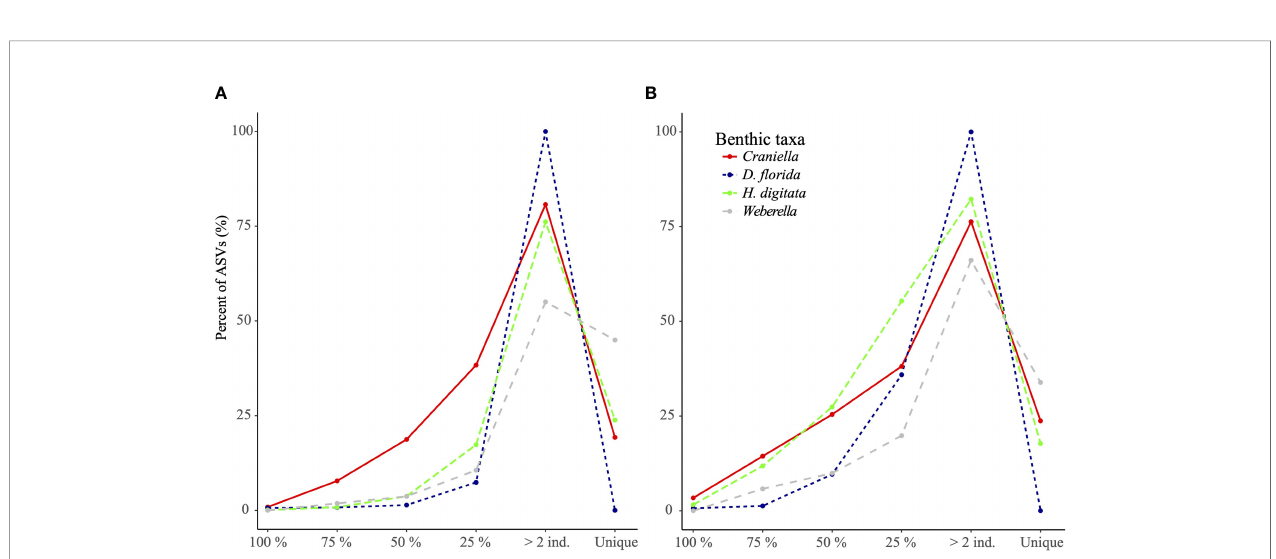
FIGURE 5 | Percentage of ASVs (A) and genera (B) per epibenthic species that were found unique to or shared across all specimens (100%), most specimens (75%), half of the specimens (50%) or at least 2 specimens.